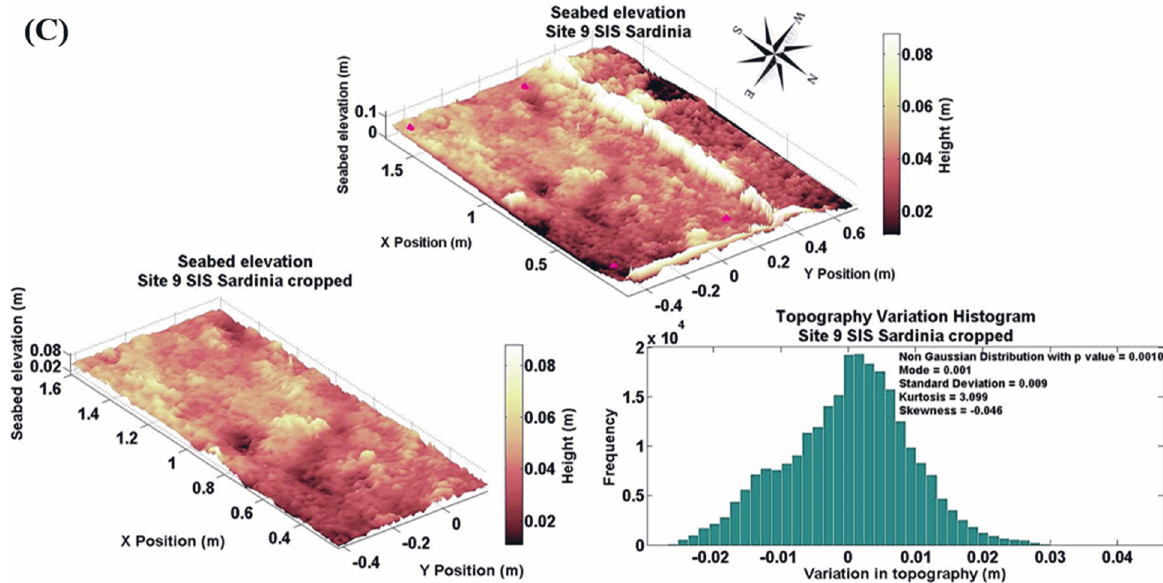
Figure 8. ( A ) Statistical analysis of seabed topography for site 4 as an example of BRAD output; ( B ) Statistical analysis of seabed topography for site 5 as an example of BRAD output; ( C ) Statistical analysis of seabed topography for site 9 as an example of BRAD output.